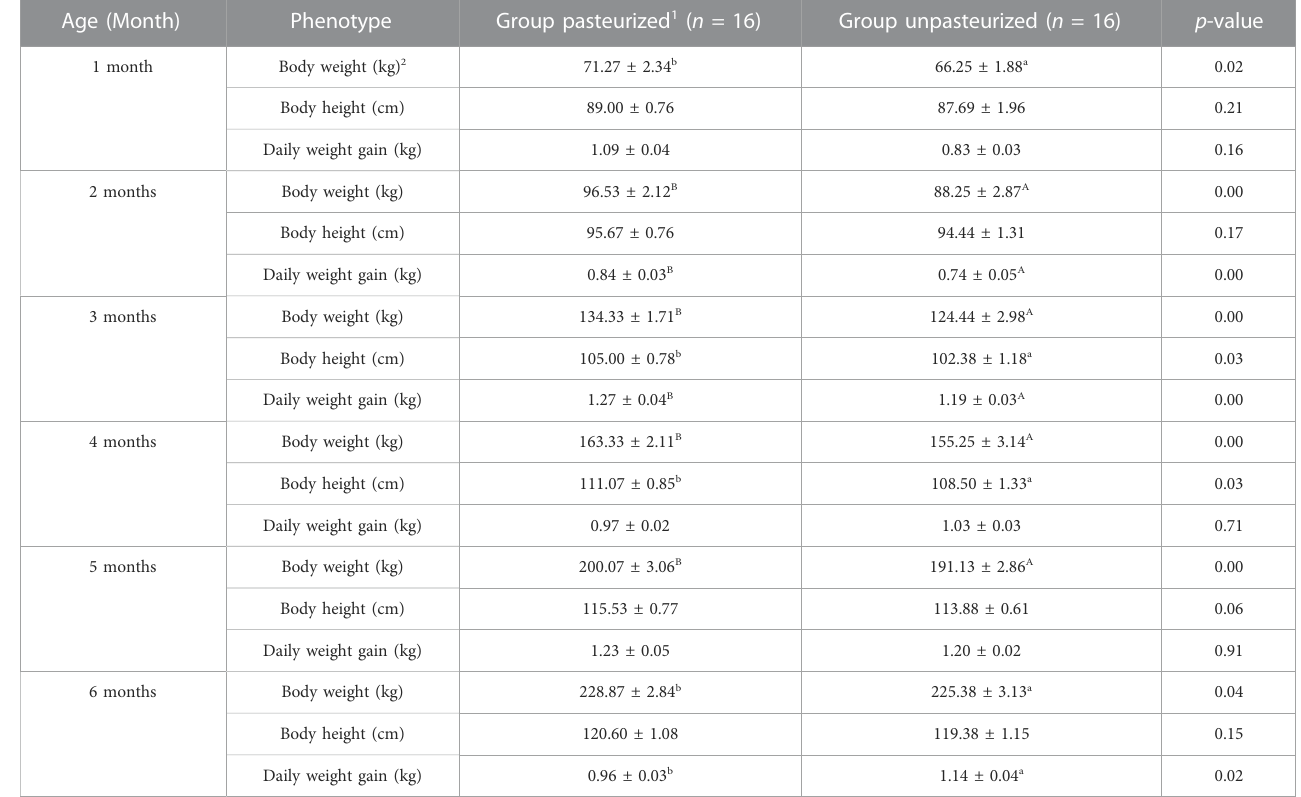
TABLE 1 Effect of pasteurized colostrum on body height, body weight and daily weight gain of calves.